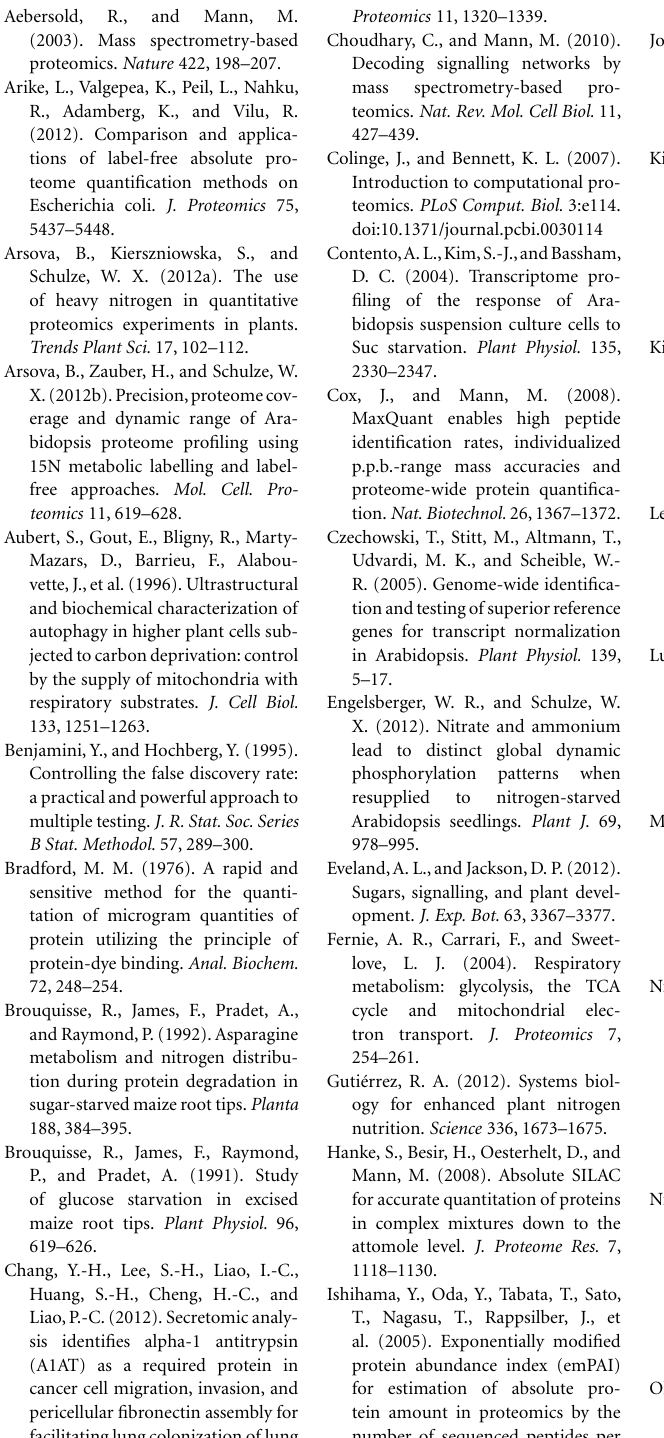
Data Sheet S1 | Intensity values of all peptides identified in the combinatorial matrix. Data Sheet S2 | RPN normalized and median averaged protein intensities from combinatorial matrix.